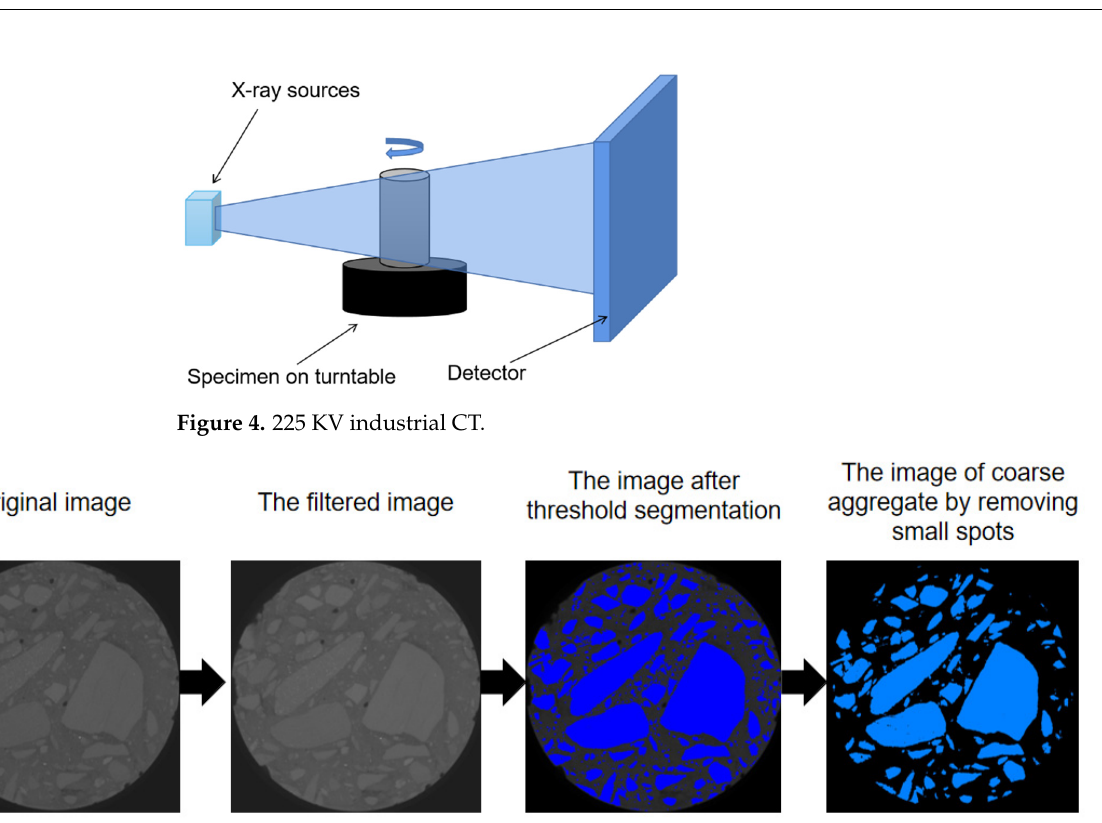
Figure 5. The processing steps of the CT images.